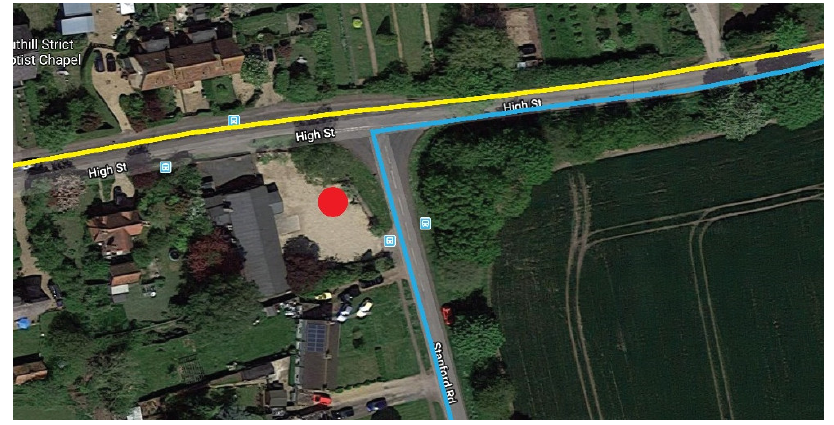
Figure 20. Screenshot of Google Maps showing routes taken and location of the base station [26].